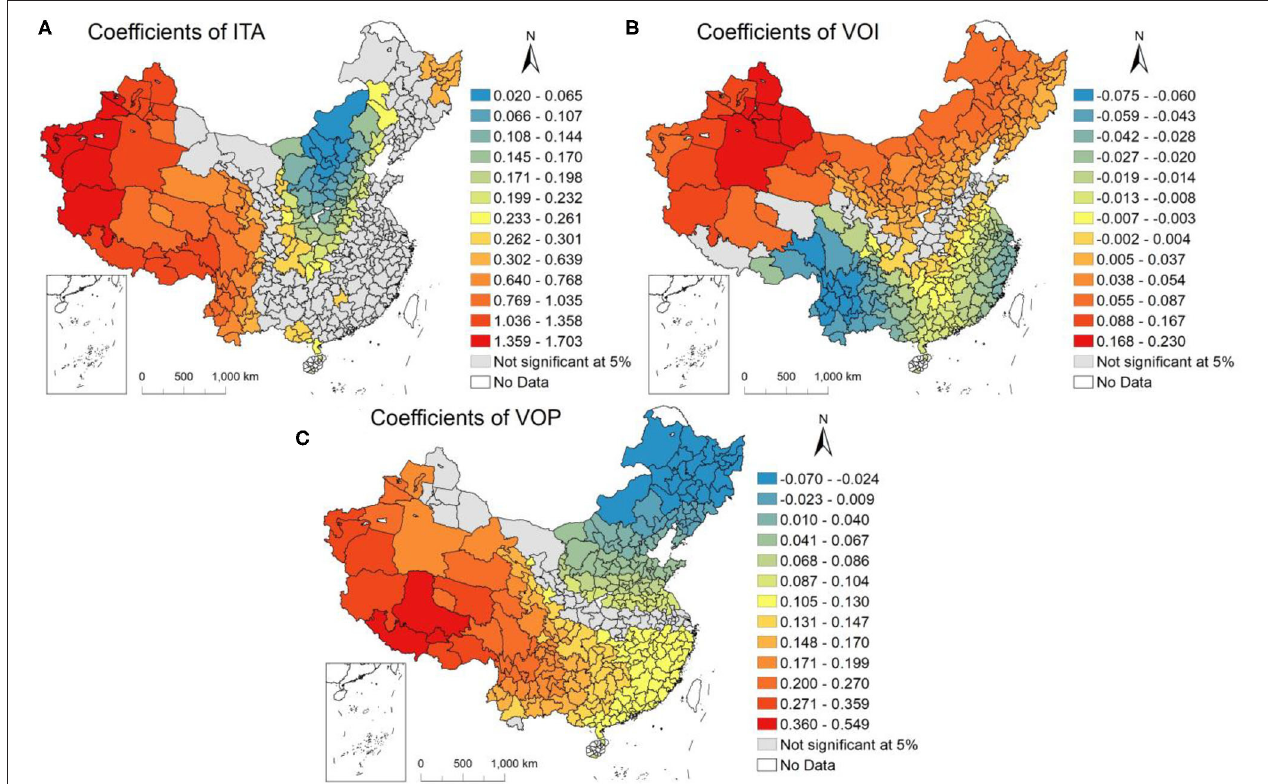
FIGURE 6 | Results of anthropogenic factors from the GTWR in 332 Chinese cities. (A) Coefficients of the intensity of trip activities (ITA), (B) coefficients of the numbers of daily pollutant operating vents of key polluting enterprises in the industrial sector (VOI), and (C) coefficients of the numbers of daily pollutant operating vents of key polluting enterprises in the power sector